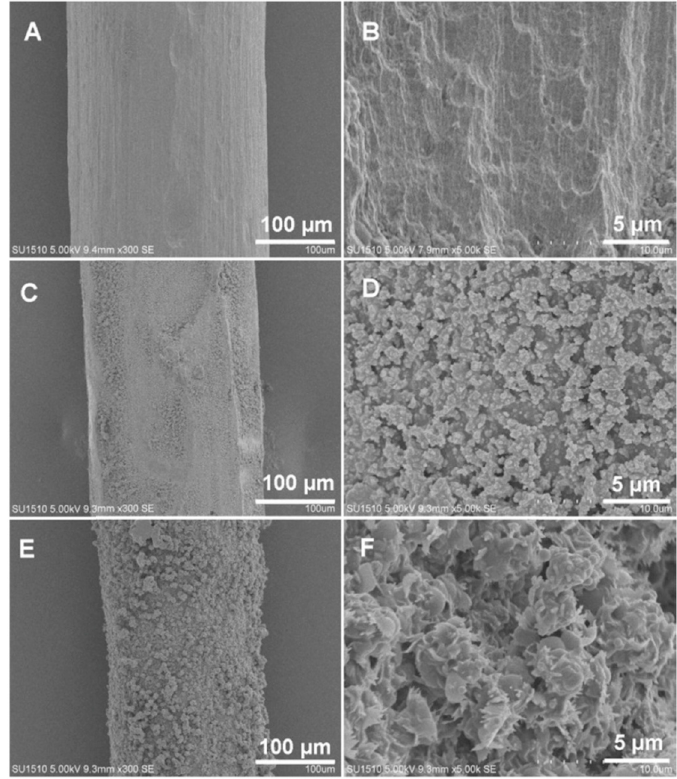
Figure 9. SEM images of an etched fiber (magnifications: 300× ( A ), 5000× ( B )), a PDA-coated fiber (magnifications: 300× ( C ), 5000× ( D )) and a Tp/BD COF bonded SPME fiber (magnifications: 300× ( E ), 5000× (F)). Reprinted from [104] with permission of Elsevier.